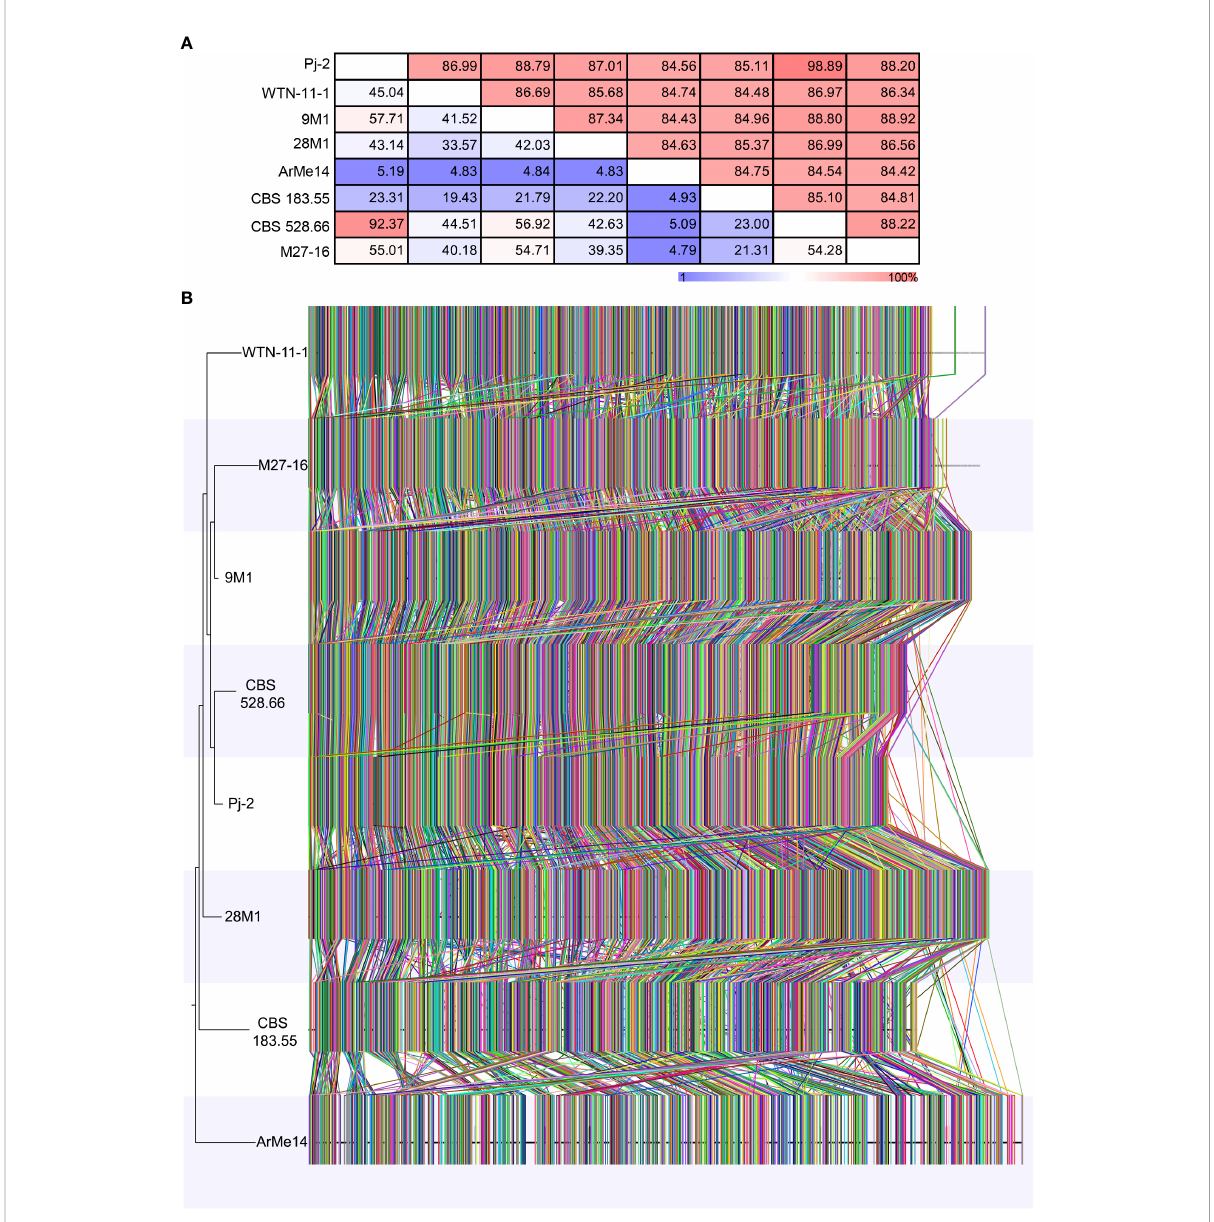
FIGURE 2 Phylogenomics of Didymella spp. The whole genomes of eight Didymella spp. strains are aligned using CLC Genomic Workbench with 50 bp seeds: D. glomerata Pj-2 (33.17 Mb; 32 scaffolds), CBS 528.66 (33.98 Mb; 177 scaffolds) and M27-16 (35.52 Mb; 946 scaffolds), D. keratinophila 9M1 (36.22 Mb; 577 scaffolds), D. heteroderae 28M1 (37.07 Mb; 620 scaffolds), D. pinodes WTN-11-157 (33.77 Mb; 1,593 scaffolds), D. exigua CBS 183.55 (34.39 Mb; 176 scaffolds) and D. rabiei ArMe14 (40.92 Mb; 34 scaffolds). The seeds were extended using a HOXD scoring matrix until the local alignment score dropped. Pairwise distance matrices between the aligned genomes are calculated from the alignment blocks of size ≥ 100 bp and are expressed as alignment percentage (AP; upper) and average nucleotide identity (ANI; lower) (A) . Genome-wide synteny analysis among the eight strains (B) . Each colored link represents a syntenic block ( ≥ 1,000 bp) that is shared among genomes. A neighbor-joining tree is also shown to the left of the whole-genome